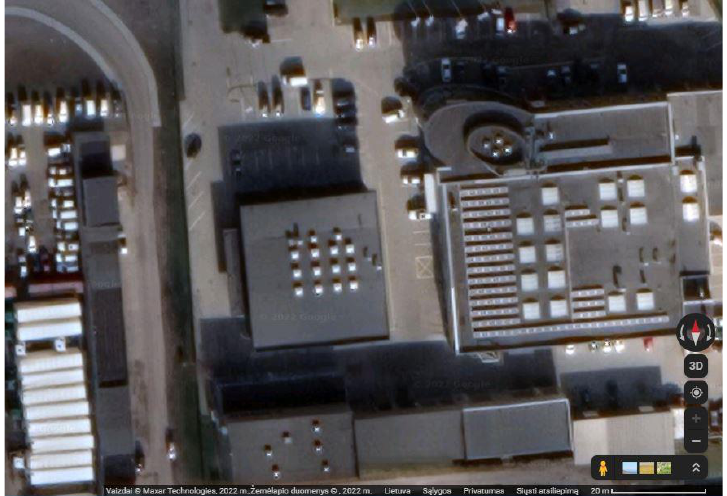
Figure 10. The view of the as-built auto repair shop. The photo was taken using the Google maps tool on 6 June 2022.